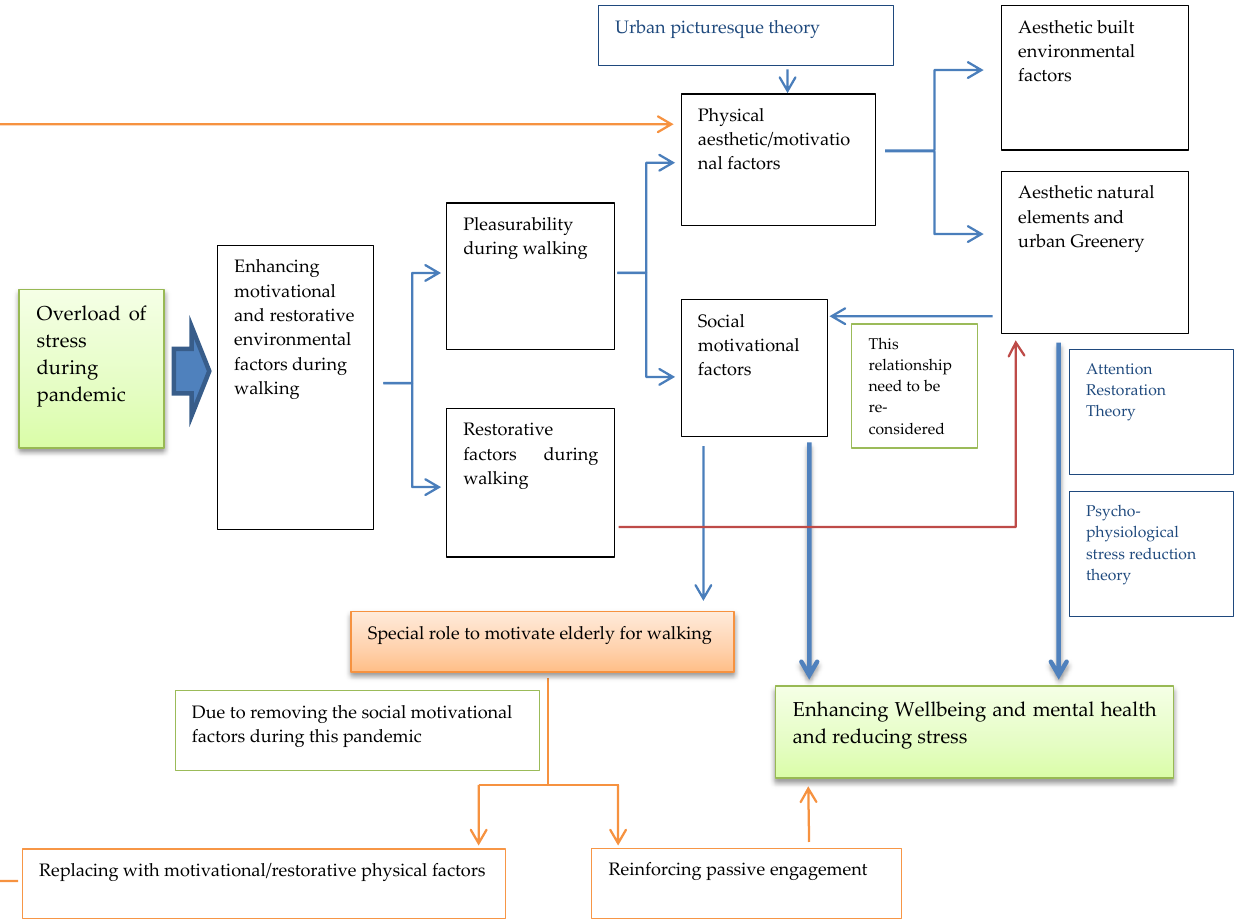
Figure 5. The process of the role of motivational/restorative environmental factors on neutralizing and reducing stress